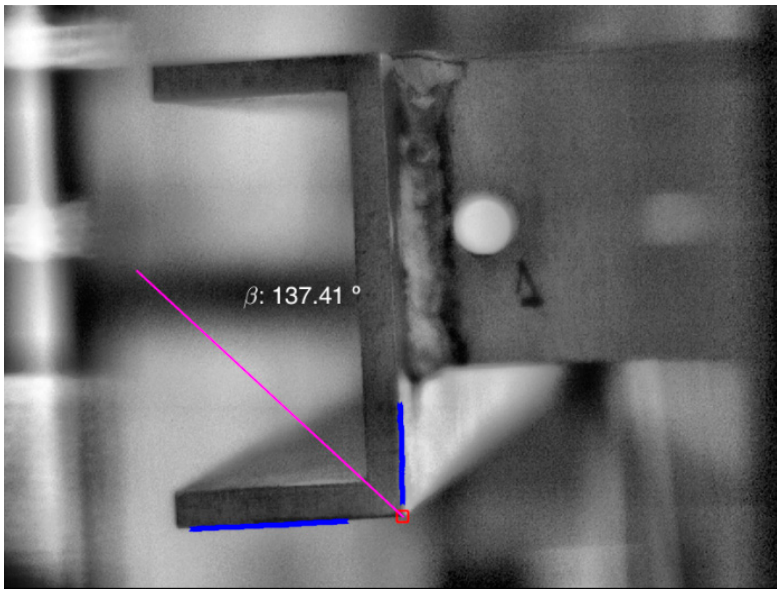
Figure 9. Frame of the recorded video (see Visualization 3) of the U-shaped beam during the experiment with the selected segments in blue, the intersection (red square), and the computed bisector (pink).